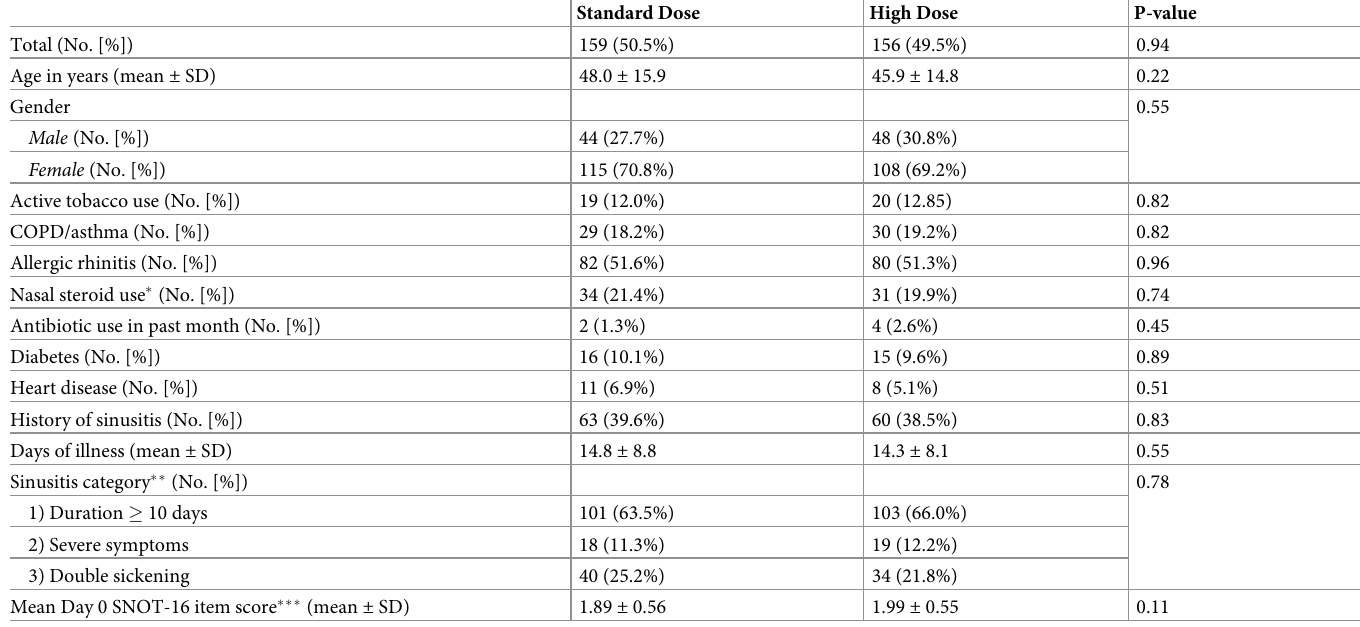
Table 2. Baseline characteristics of participants as a whole by dose.